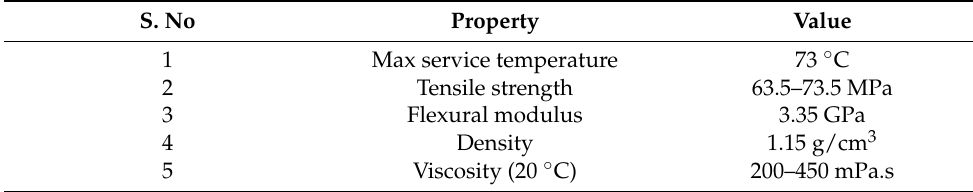
Table 2. Epoxy resin properties.